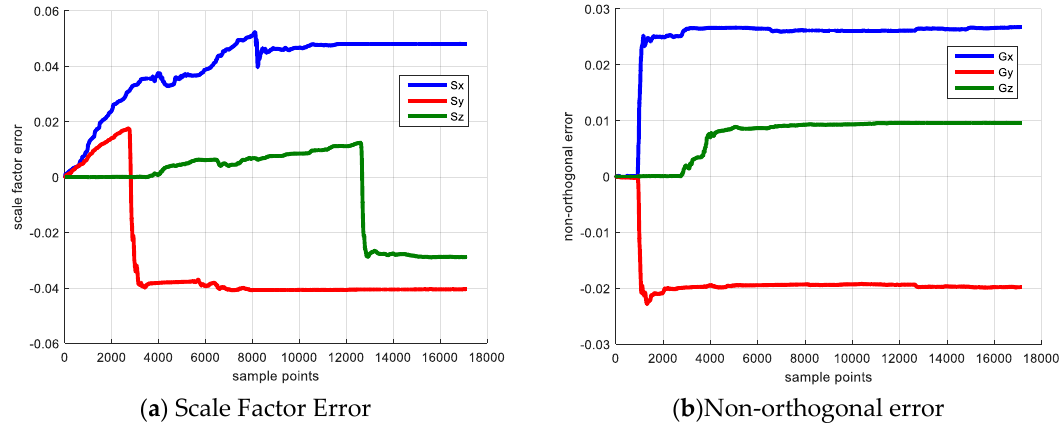
Figure 2. Sensor Error Calibration Result.